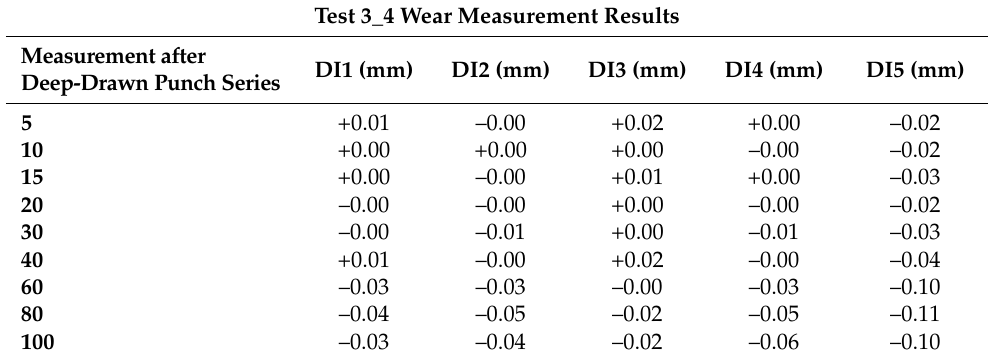
Figure 9. Wear of punch in Test 3_4 between 5 ( left ) and 100 pieces ( right ). All values are in mm unit. Table 13. Wear of punch in Test 3_4 between 5 and 100 pieces, measured values at given points.